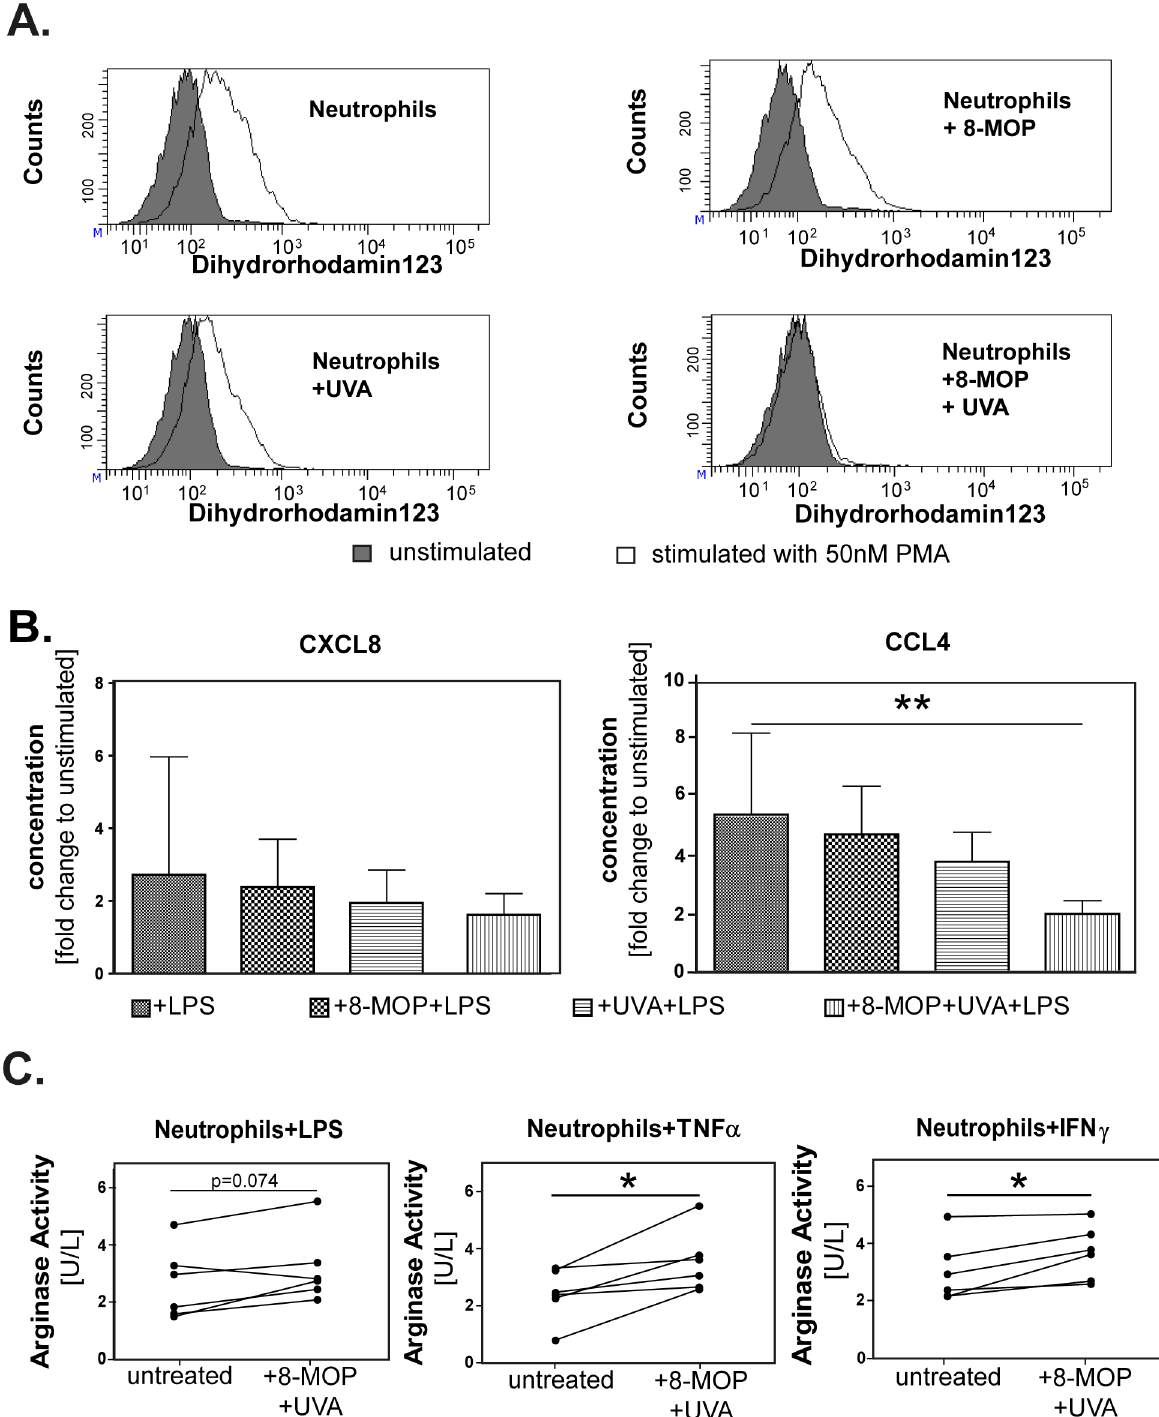
Fig 3. In vitro treatment with 8-methoxypsoralen and UVA reduces pro-inflammatory effector functions in healthy donor neutrophils. (A) Neutrophil granulocytes of healthy donors were stimulated with phorbol 12-myristate13-acetate (PMA) for 0, 4, 8 and 24h after treatment with 8-methoxypsoralen and UVA light. Nitric oxide was quantified via flow cytometry by staining with DAF-FM Diacetate after gating on viable cells. Data shown from one representative donor. (B) After 24h of stimulation with LPS, release of CXCL8 and CCL4 into the supernatants was detected by ELISA. Concentrations are shown as x-fold change compared to unstimulated neutrophils. Mean changes of 6 donors ± standard deviation (SD) shown. ** p (cid:3) 0.01. (C) Supernatants of untreated neutrophils and neutrophils treated with 8-MOP and UVA were generated after 24h stimulation with LPS, TNF α and IFN γ (n = 6). Arginase activity was determined enzymatically. Unit definition: 1 unit of arginase converts 1 μ mol of L-arginine to ornithine and urea per minute at 37°C and pH 9.5. * p = 0.04 doi:10.1371/journal.pone.0134518.g003 PLOS ONE | DOI:10.1371/journal.pone.0134518 August 4,